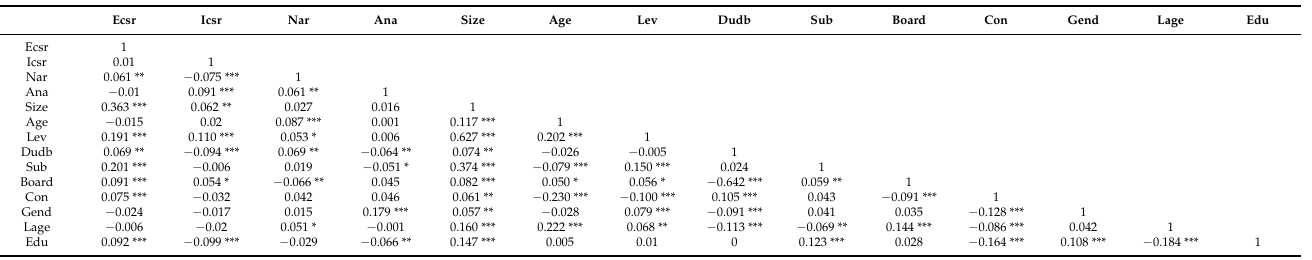
Table 3. Main Variables Correlation